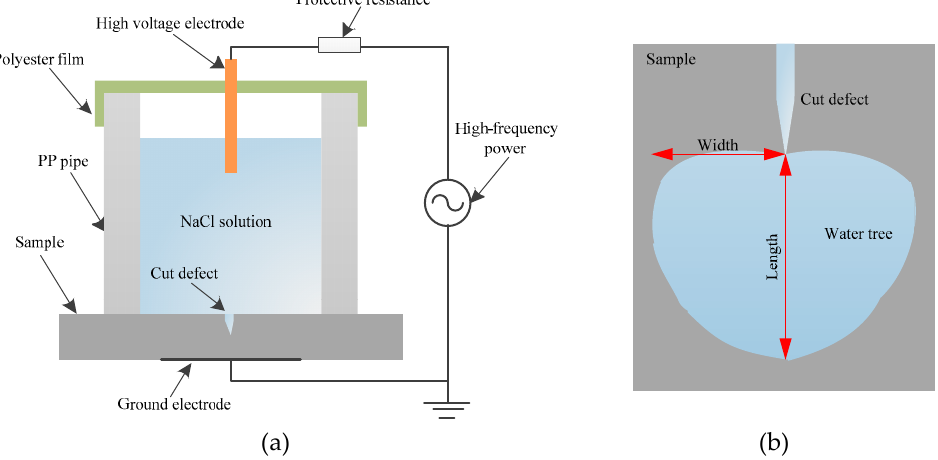
Figure 1. Schematic water knife electrode system: ( a ) experimental installation, and ( b ) water tree region.